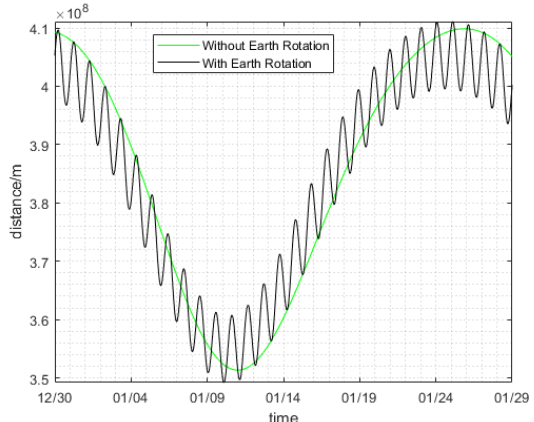
Figure 4. The approximate distance between MBS and its corresponding EGT with Earth rotation (the black solid line) and without Earth rotation (the green solid line) as recorded in January, 2001. The curve occlusion of the spheres between MBS and EGT are not considered.